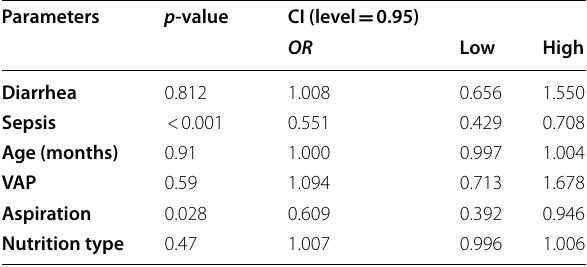
Regression analysis done by the Hosmer–Lemeshow test (HL